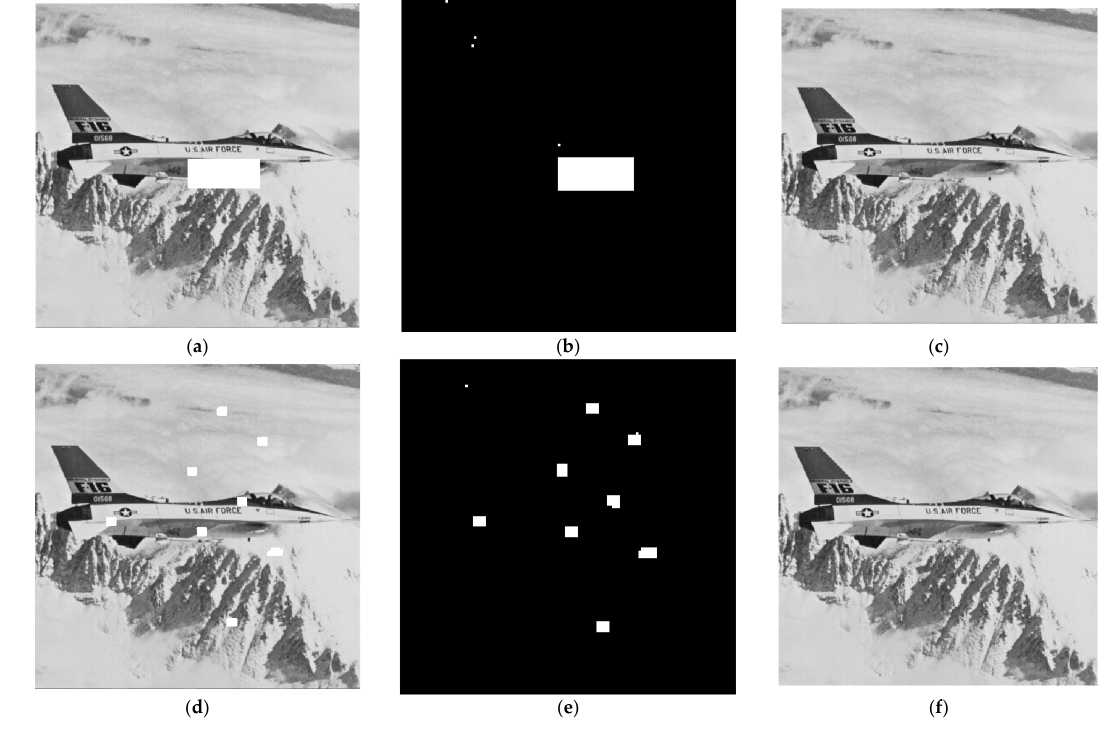
Figure 11. The visual performance for Airplane: ( a ) Cutting attack 1, ( b ) Detection of ( a ), ( c ) Recovery of ( a ), ( d ) Cutting attack 2, ( e ) Detection of ( d ), and ( f ) Recovery of ( d ).